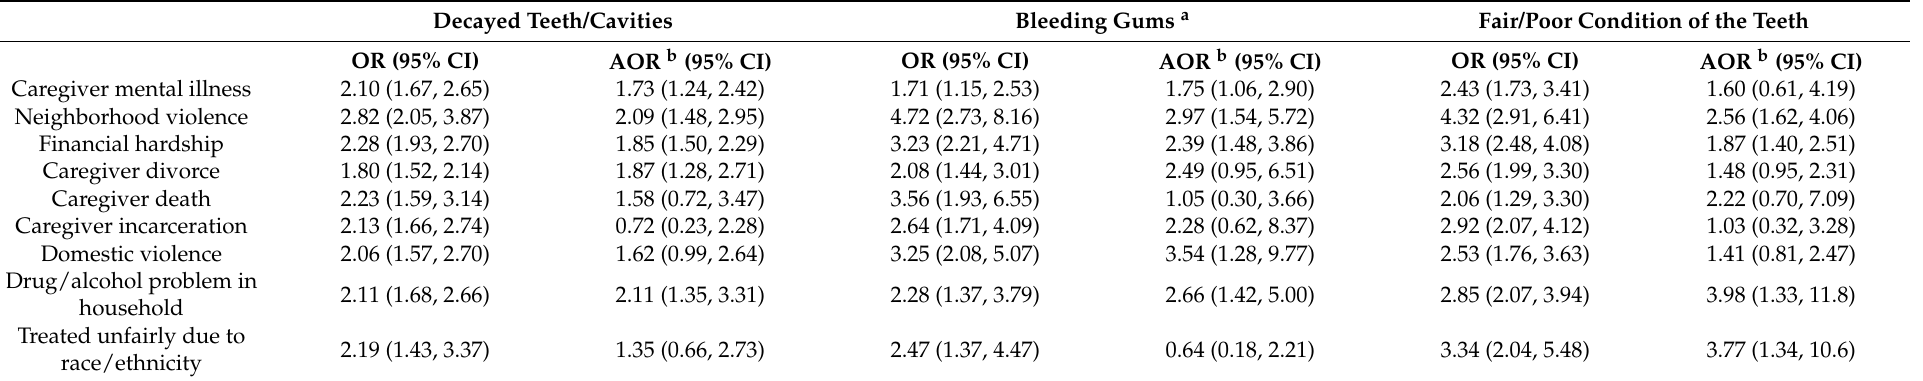
Table 3. Unadjusted and adjusted associations between past year exposure to Adverse Childhood Experiences and past year oral health outcomes, NSCH